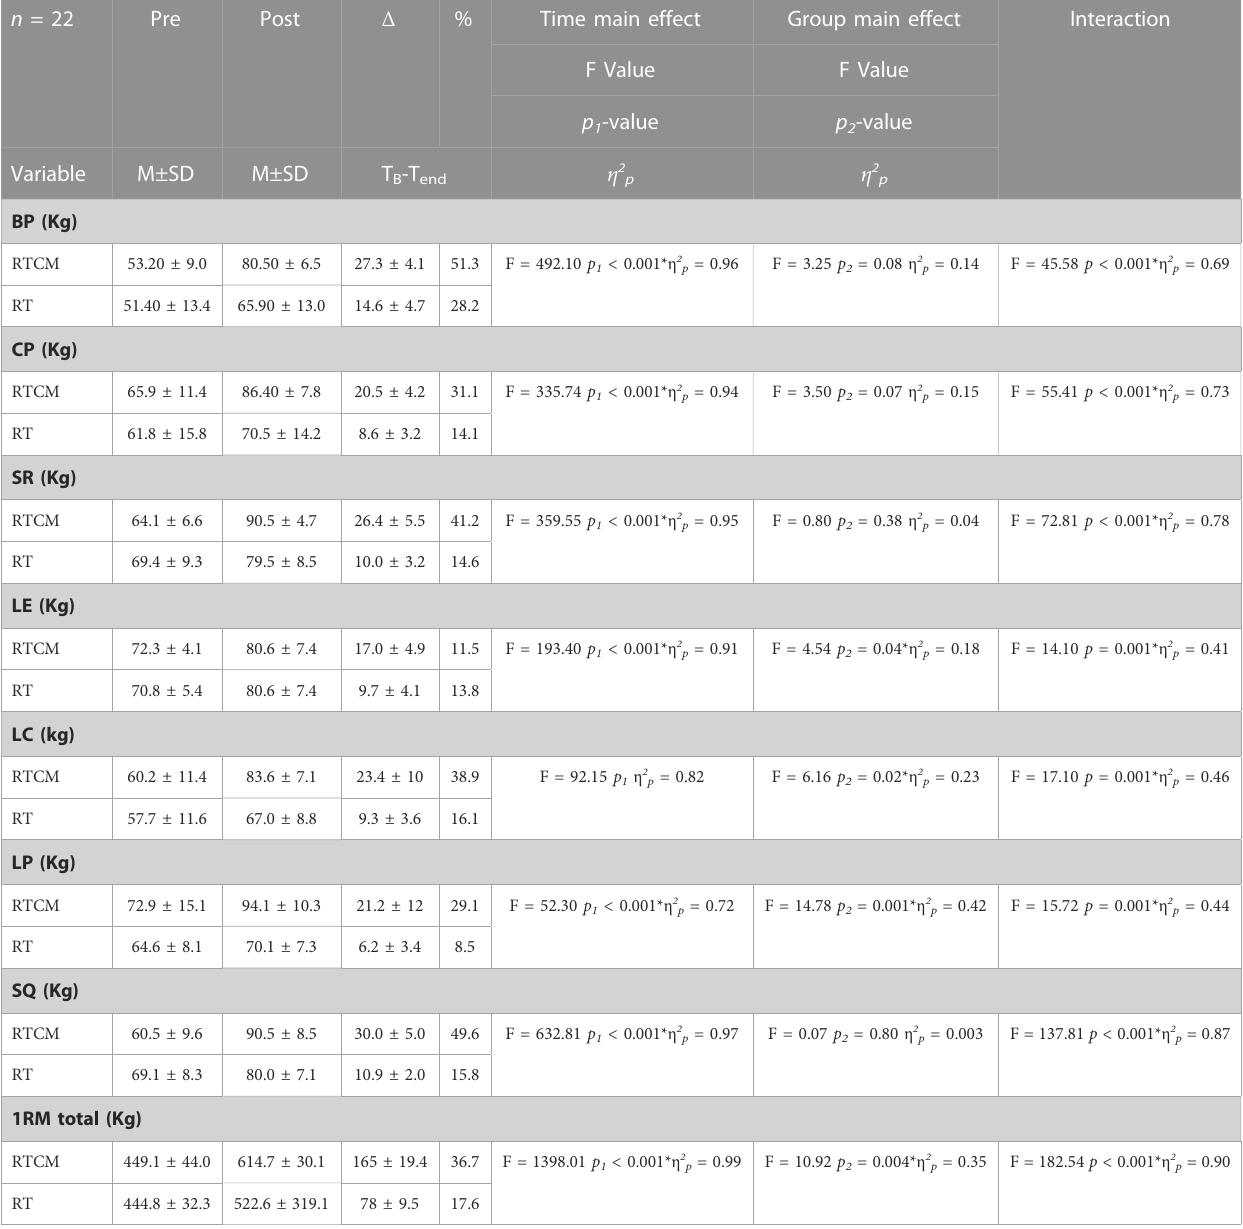
TABLE 4 Baseline and post-test results of 1 RM values. n = 22